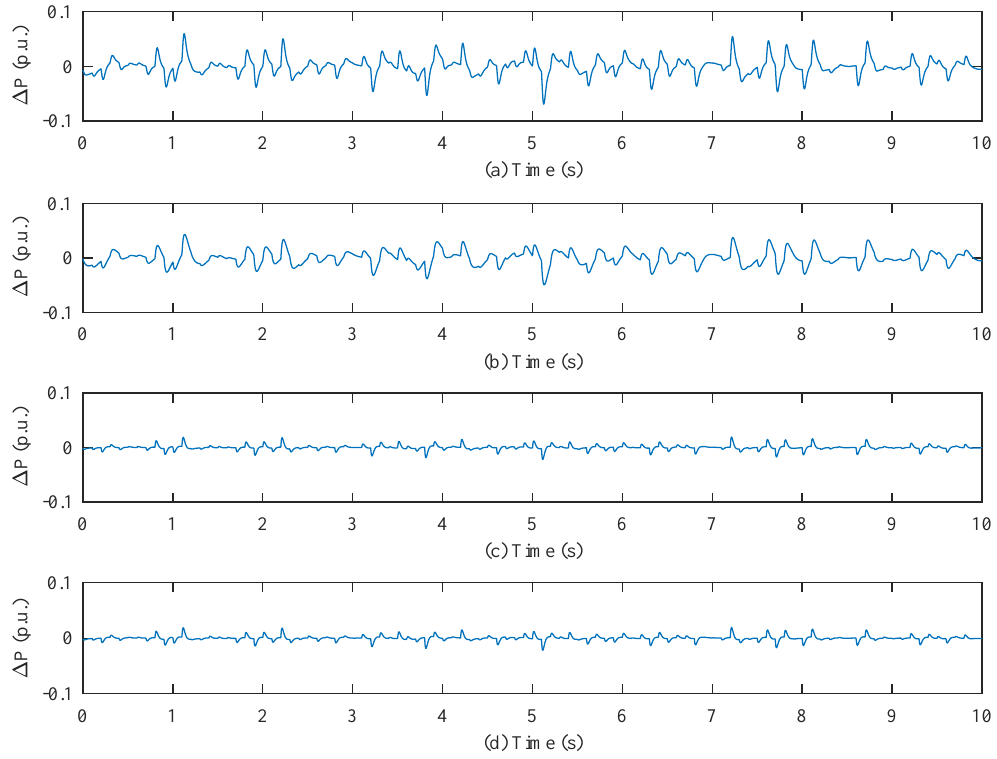
Figure 15. Transient response of supply-demand mismatch with stochastic disturbance. ( a ) Supply- demand mismatch based on CCS-ILADRC without time delay; ( b ) supply-demand mismatch based on CCS-ILADRC with 10-ms delay; ( c ) supply-demand mismatch based on DCS-ILADRC without time